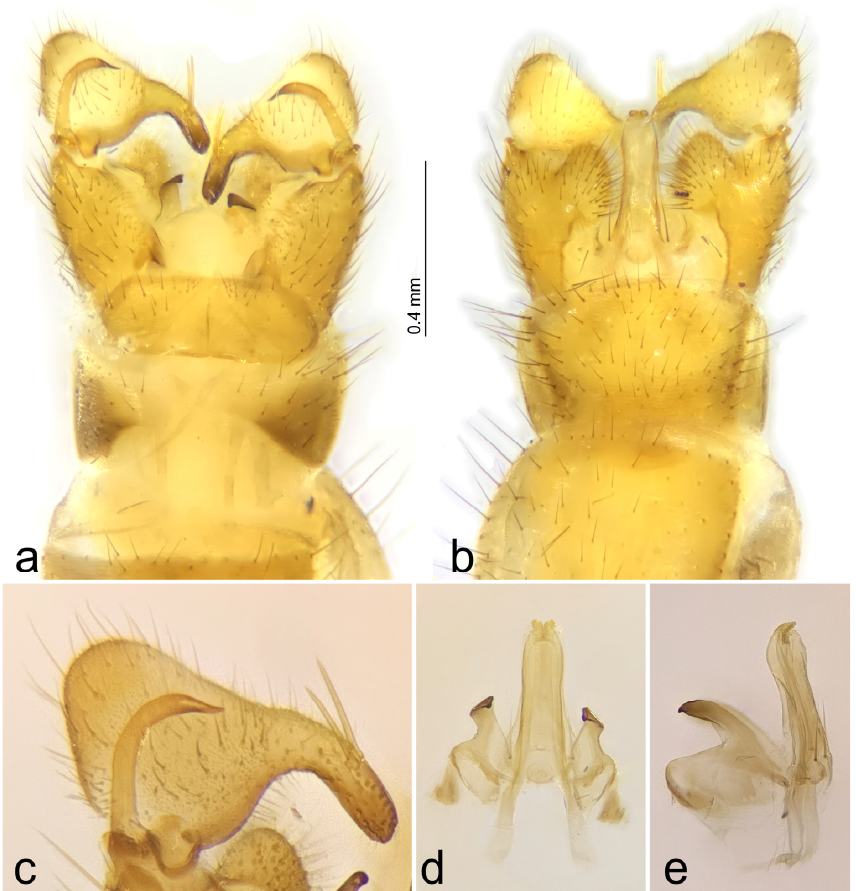
Figure 6. Rhipidia (Rhipidia) martiniquensis sp. nov., holotype male; ( a ) Hypopygium in dorsal view; ( b ) idem in ventral view; ( c ) Outer and inner gonostyli in lateral view; ( d ) Aedeagal guide and parameres in dorsal view; ( e ) idem in lateral view.